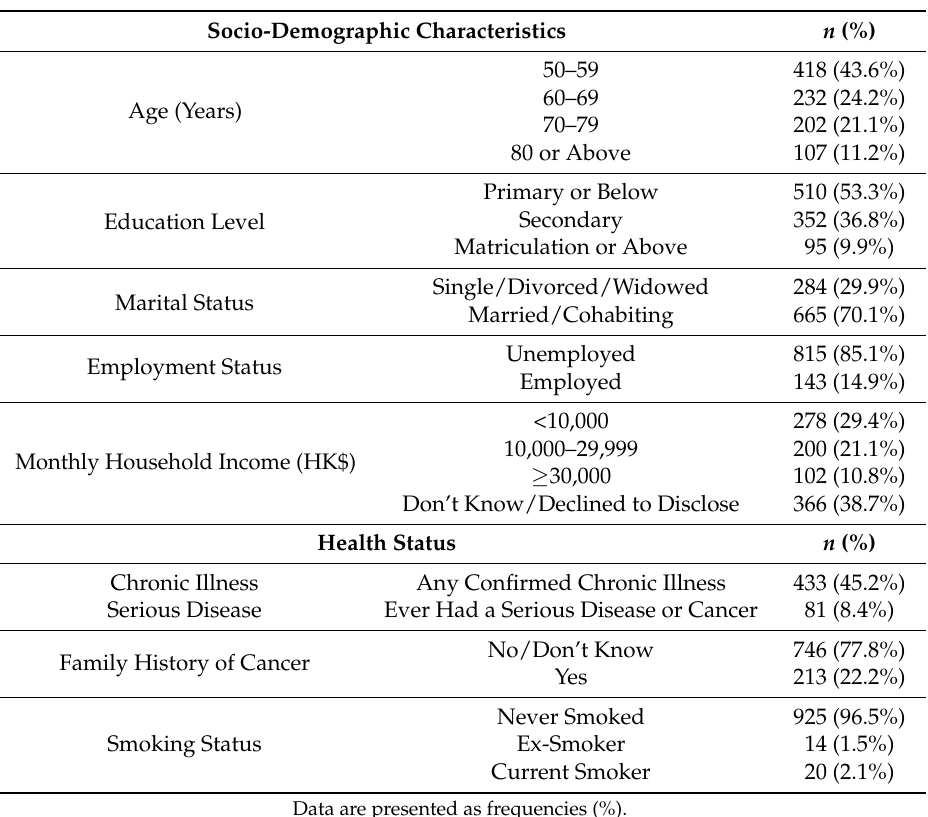
Table 1. Socio-demographic characteristics and health status of the respondents ( n =